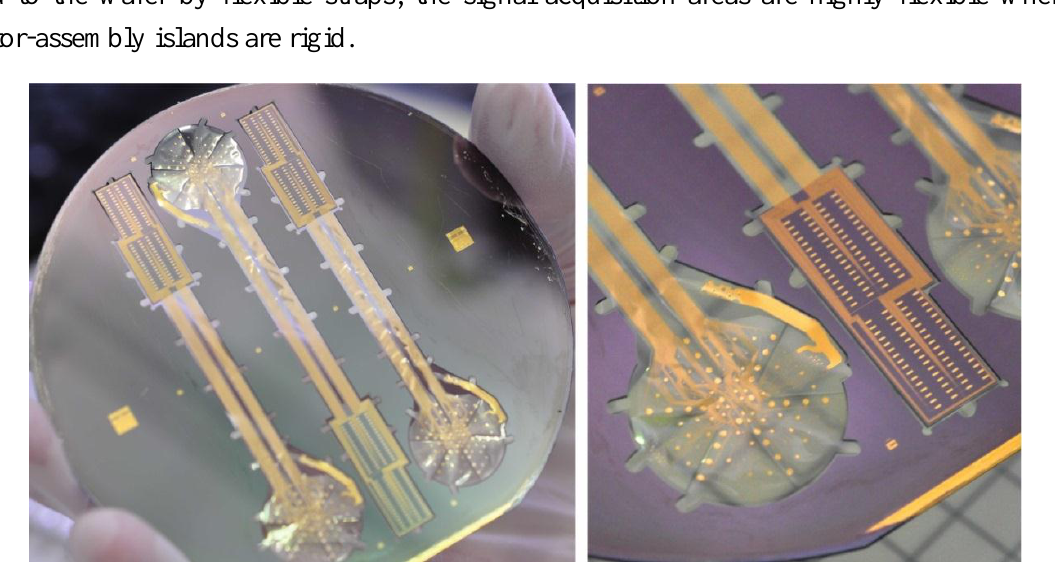
Figure 6. A 4" wafer which contains three flex-rigid ECoG devices.